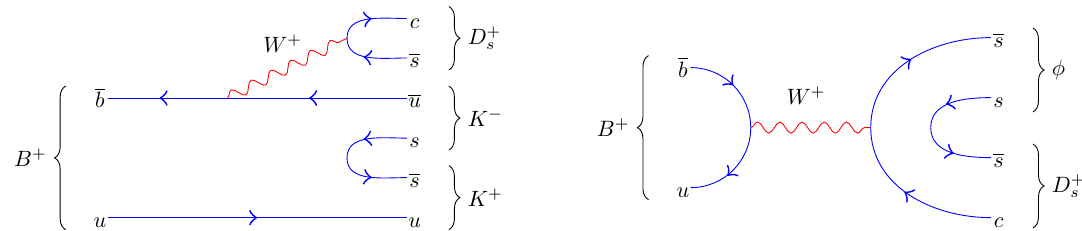
Figure 1. Dominant diagram for the (left) B + ! D + diagram for the B + ! D + (cid:30) decay in the Standard s